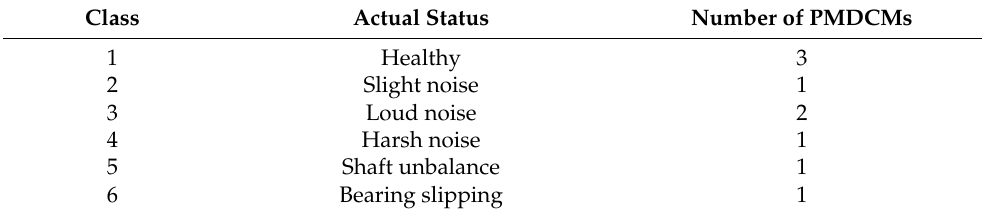
Figure 4. The fault diagnosis platform for PMDCMs. The studied PMDCMs fall under six categories: healthy, slight noise, loud noise, harsh noise, shaft unbalance, and bearing slipping, as shown in Table 4. Table 4. Categorization for healthy and faulty PMDCMs.